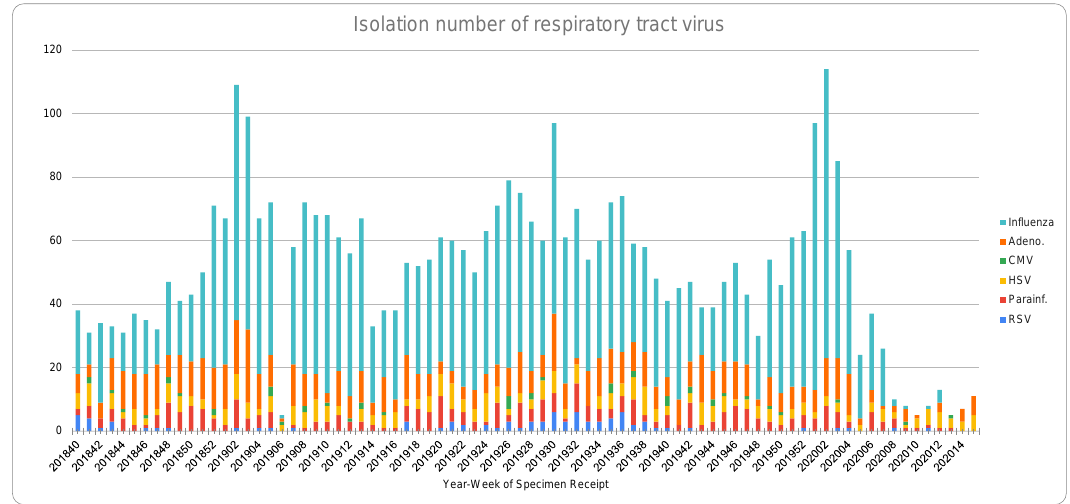
Figure 3. Isolation number of respiratory tract virus. Note: year-week specimen receipt from randomly selected samples of respiratory disease, data extracted from the Taiwan National Infectious Disease Statistics System [6]. It shows the number of isolates representing the distribution of most commonly seen viral infection cases selected from ILI cases. It is the aggregation of two nationwide randomly selected samples from each of the 160 sample taking stations. x axis: year-week interval & y axis: number of cases.